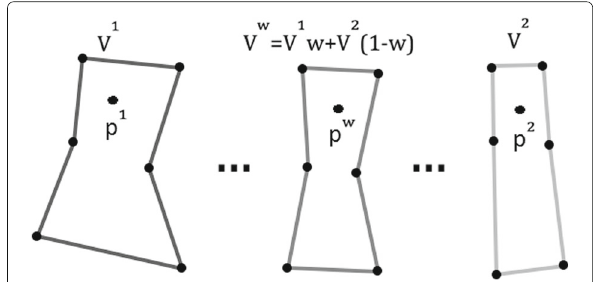
Fig. 4 Intermediate cage. Illustration of the interpolation of the intermediate cage in morphing